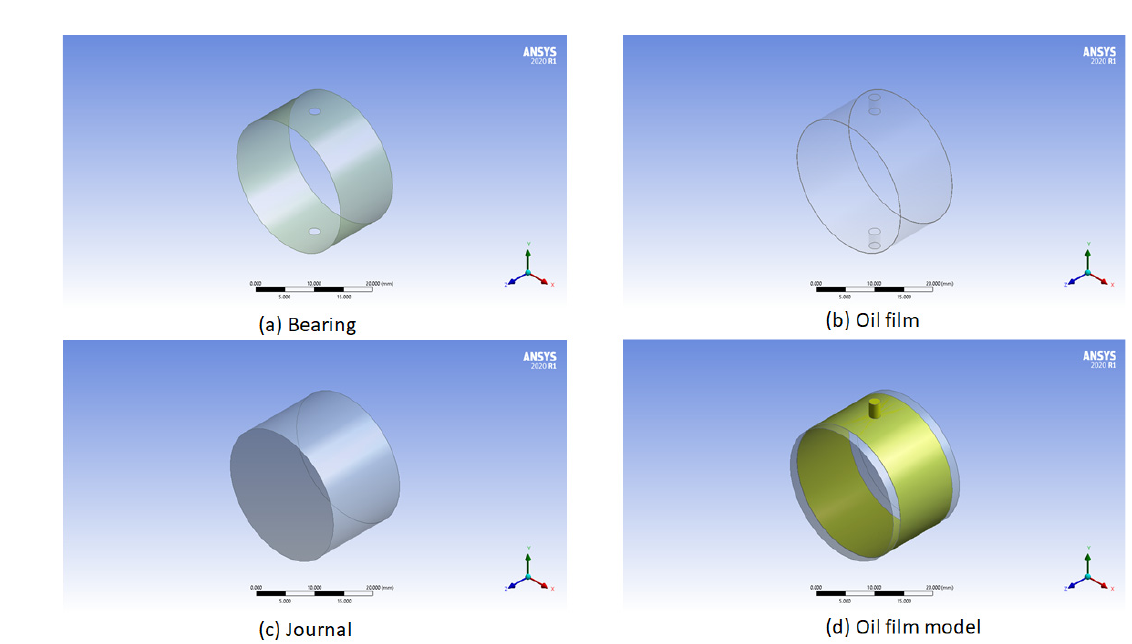
Figure 2. Ansys oil film